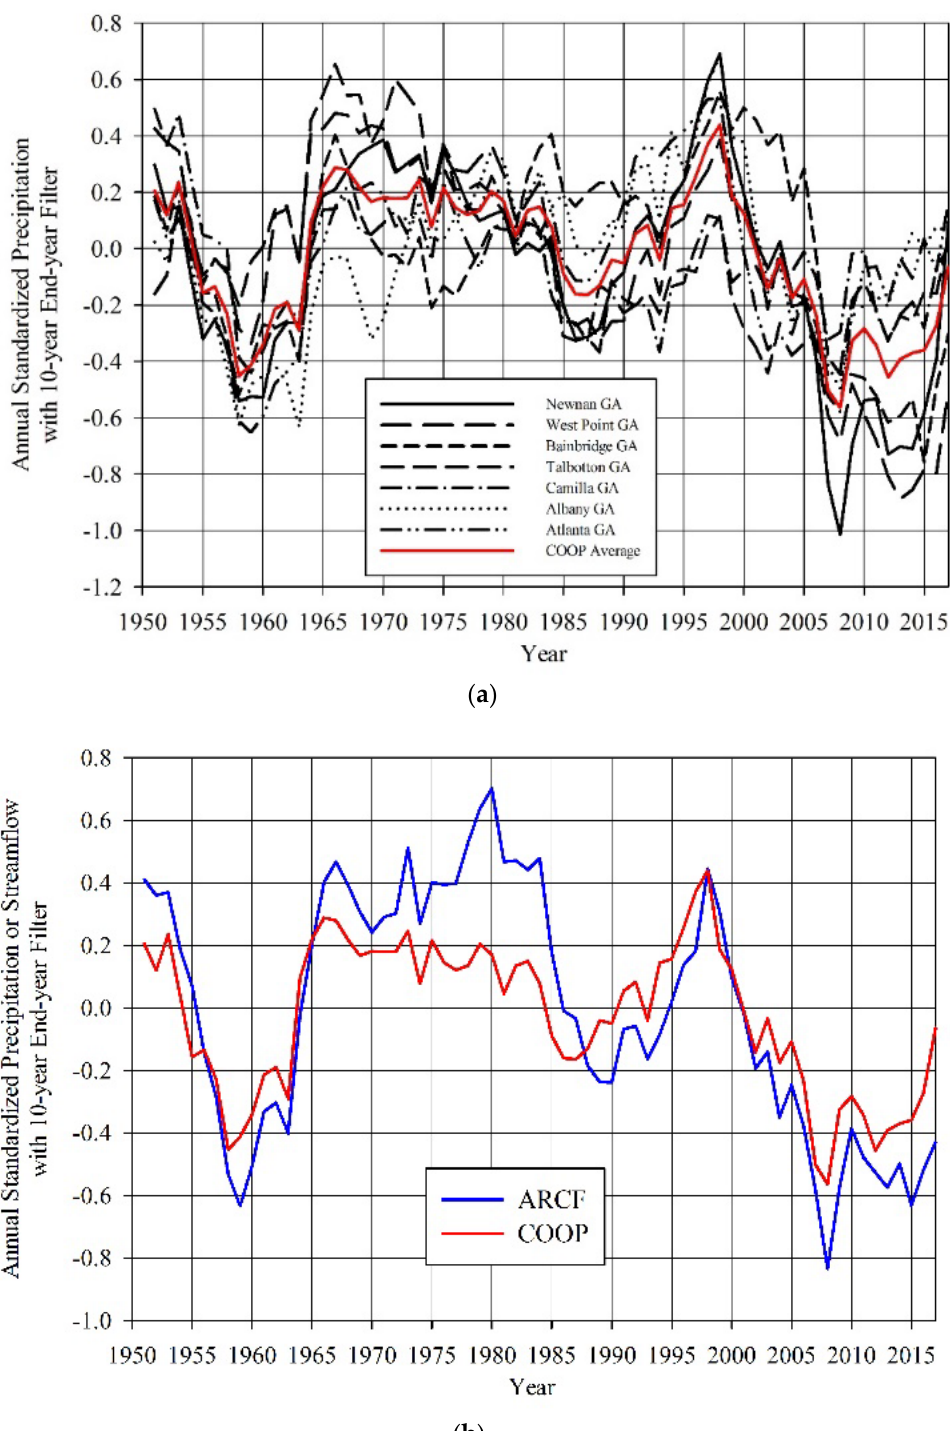
Figure 2. Annual standardized streamflow with 10-year end-year filter ( a ) Streamflow: 1970-2017 (based on annual data of 1961-2017) ( b ) streamflow: 1951-2017 (based on annual data of 1942-2017).